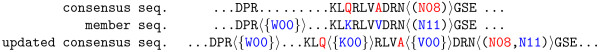
Information-preserved protein clustering example. Once a consensus sequence is selected, members of a cluster are merged into the consensus one-by-one. This figure illustrates how the information of a member sequence is merged into the consensus sequence. Amino acid followed by two zeros indicates an annotated SAP. Every annotated PTM has a two-digit positive integer that is used to distinguish different modifications. The difference in the primary sequences between a member and the consensus introduces cluster-induced SAPs. In this example, the residues Q and A (in red) in the consensus are different from the residues K and V (in blue) in the member sequence. As a consequence, K becomes a cluster-induced SAP associated with Q and V becomes a cluster-induced SAP associated with A. The annotated SAP, ⟨{W00}⟩, associated with residue R in the member sequence is merged into the consensus sequence, see the updated consensus sequence in the figure. Note that the annotated PTM, ⟨(N11)⟩, associated with N in the member sequence is merged with a different annotated PTM, ⟨(N08)⟩, at the same site of the consensus sequence. In this figure, all the merged information from the member sequence are shown in blue color to indicate that during the searches we can choose to respect the correlated information from each member sequence separately. To respect the correlated information means that when scoring the peptide segment LQ ⟨{K00}⟩ RLVA ⟨{V00}⟩ DR of the consensus sequence RAId_DbS only considers the combinations L(red Q)RLV(red A)DR and L(blue K)RLV(blue V)DR, but not L(red Q)RLV(blue V)DR and L(blue K)RLV(red A)DR. Having the choice to distinguish the SAPs/PTMs originated from individual member sequences, RAId_DbS can target on documented SAP/PTM combinations associated with certain disease (if it exists) and can avoid scoring unnecessary SAP/PTM combinations when there are several variable sites occurring within a peptide. However, currently we find almost no incidence of multiple variable sites within a short peptide in all our databases constructed. Therefore, the feature of respecting correlated information is only implemented in our in-house version, not yet in the web version. Furthermore, not forcing the integrity of correlated information also allows for novel SAP discovery in a controlled fashion, meaning that one is looking for SAPs with local precedence. Finally, let us emphasize that although the SAPs, PTMs are merged each annotation's origin and disease associations are kept in the processed definition file, allowing for faithful information retrieval at the final reporting stage of the RAId_DbS program.